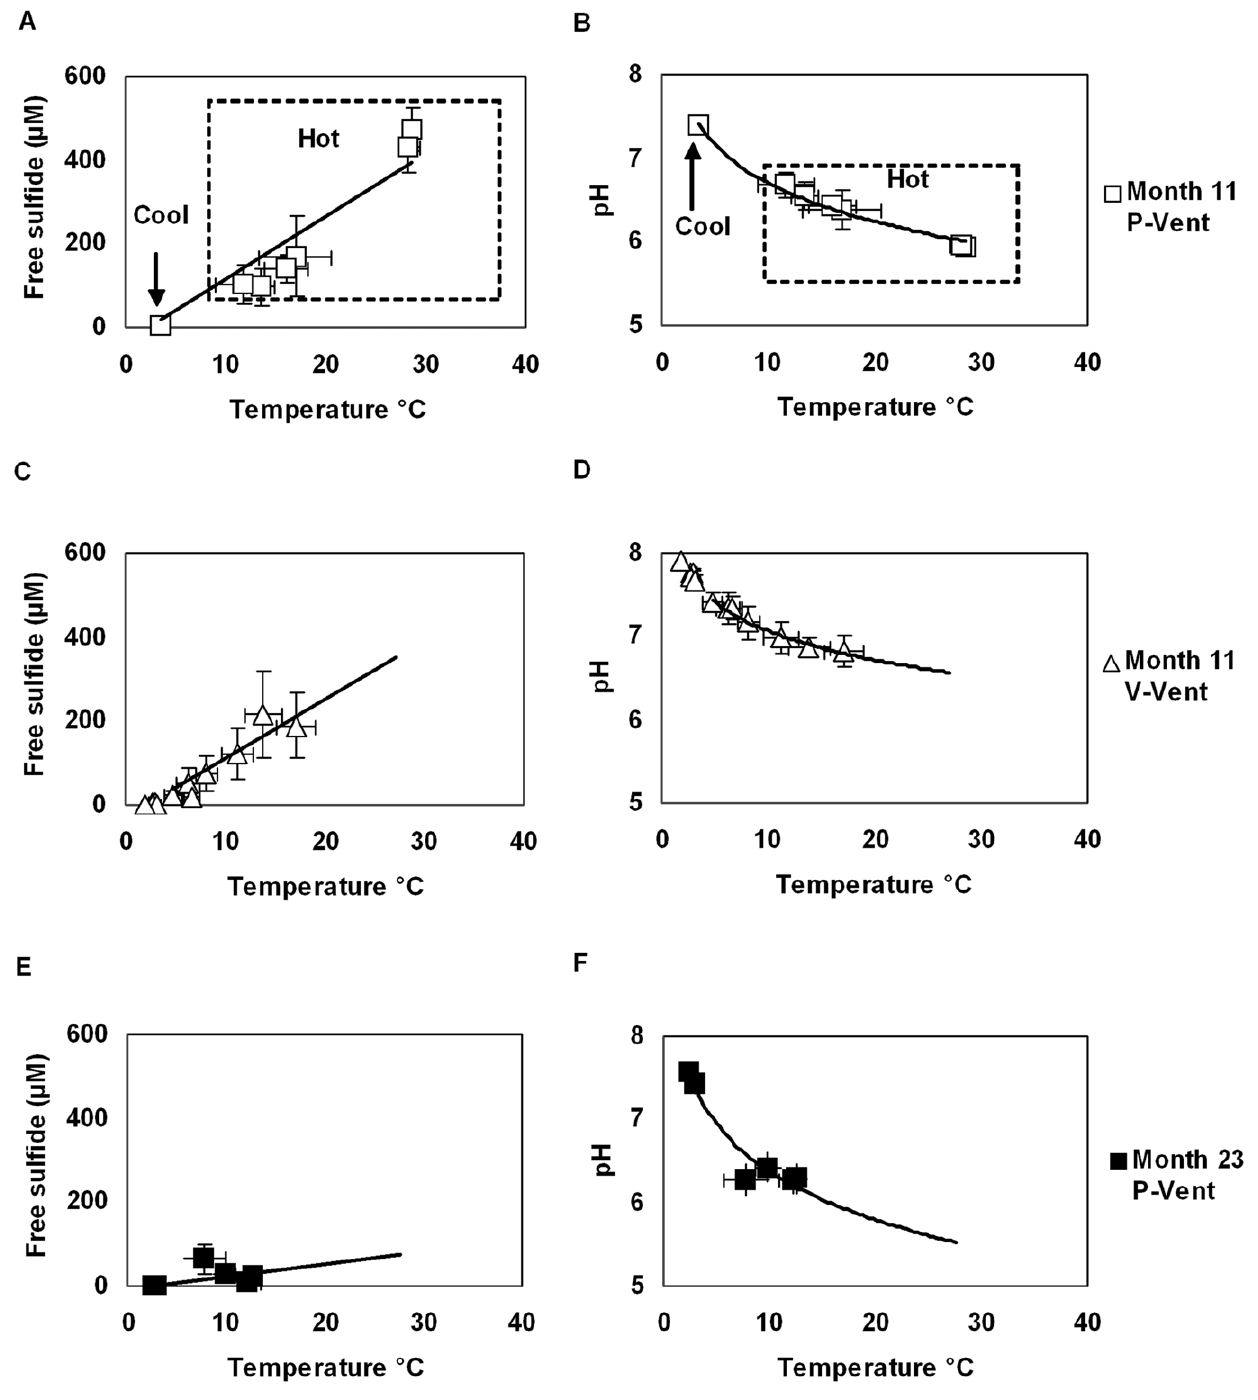
Figure 2. Variability of habitat conditions at P-vent and V-vent at 11 and 23 months after eruption. Mean and standard deviation are displayed for each measurement location. Free sulfide and pH are displayed as function of temperature, together with the corresponding regression curve (linear and logarithmic models respectively). Curves were extrapolated to 30 u C in C–F for comparison. (A, B) hot and cool habitats at 11 months at P-vent; (C, D) hot and cool habitats at 11 months at V-Vent; (E, F) hot habitat at 23 months at P vent. Statistics for individual scans are in Table 2; statistics pooled for sites are in Table S1.